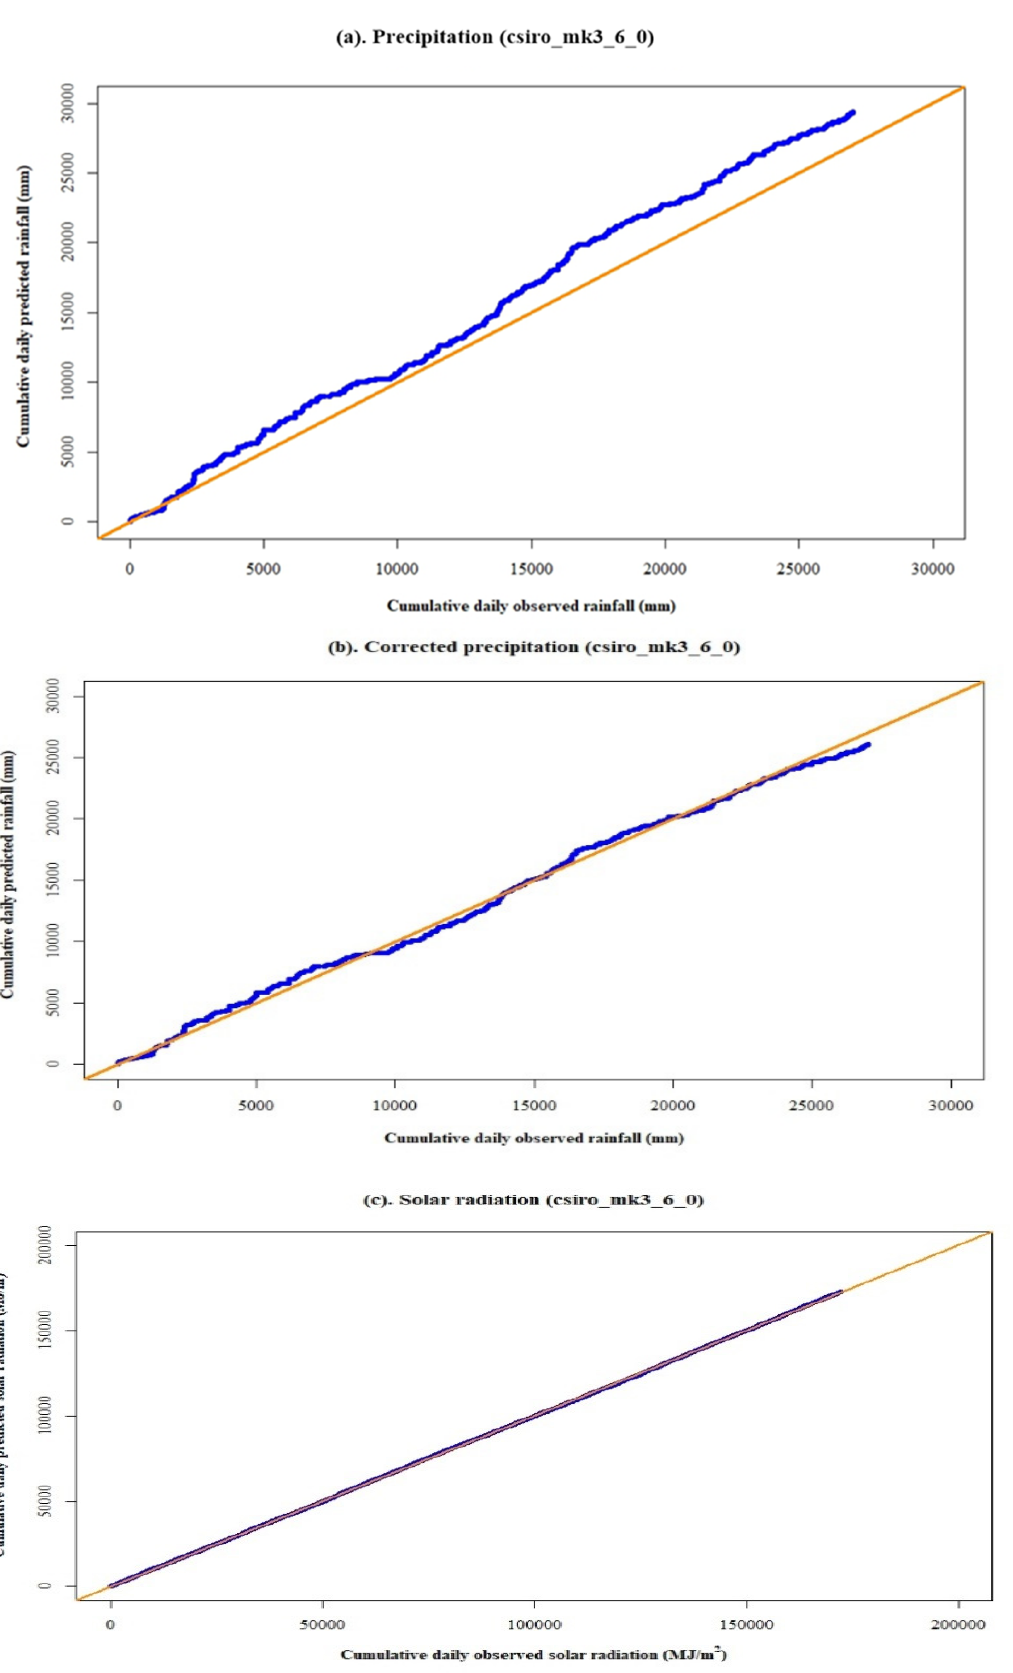
Figure 7. Double mass curve plots for the precipitation ( a , b ) and solar radiation data ( c ) by the model, csiro_mk3_6_0, for the baseline period (1980–2004).